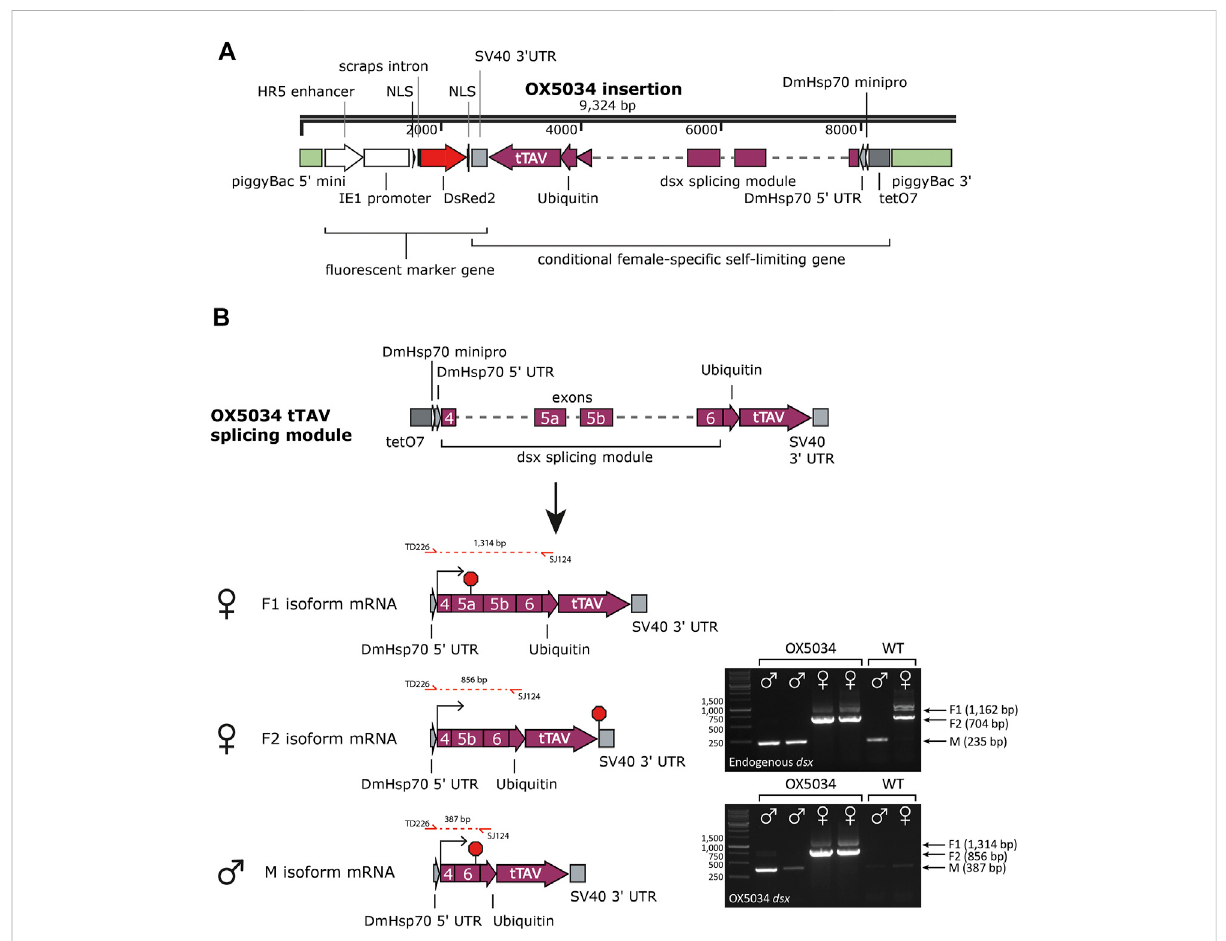
FIGURE 1 (A) Linear plasmid map showing the two genes (DsRed2 and tTAV) between the non-autonomous vector piggyBac sequences, inserted in the OX5034 Aedes aegypti strain. Due to the splicing module tTAV protein is only expressed in females in the absence of tetracycline family antibiotics. (B) Sex-speci fi csplicingofendogenous Aeadsx andofthe Aeadsx -ubiquitin-tTAVgenewascon fi rmedin Aedesaegypti mosquitoes(pupallifestage, mosquitoesrearedwithdoxycyclineintherearingmedium)byRT-PCRreactionsusingeitherprimersSS1997andTD3349(endogenous dsx ),or TD226andSJ124(OX5034 dsx ).Allsplicingisoformsoftheendogenous Aeadsx gene(M,F1andF2)weredetectedinWTaswellasOX5034mosquitoes in a sex-speci fi c manner. The Aeadsx -ubiquitin-tTAV gene was also splicing in a sex-speci fi c manner and was only detectable in mRNA extracted from OX5034 Aedes aegypti mosquitoes. In the absence of tetracycline antibiotics, the F2 isoform mRNA results in female-speci fi c tTAV protein expression, and dsx and ubiquitin amino acids are cleaved from tTAV protein by endogenous cellular processes. Red octagons indicate stop